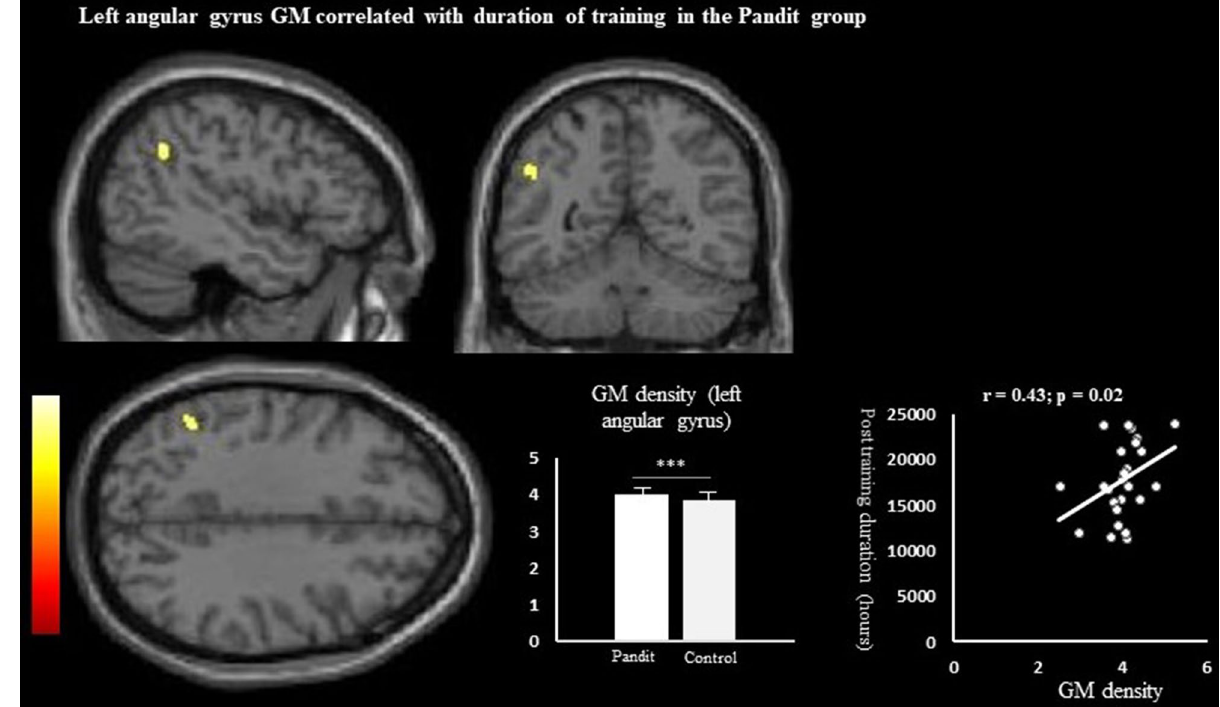
Figure 5. Result of the whole brain corelation analysis with GM value using length of post training teaching duration (hours) as a covariate in Pandit/Priest group. The result rendered into standard stereotactic space and superimposed on to transvers, sagittal and coronal section of magnetic resonance image (MRI) which is itself in standard space at a threshold of P < 0.05 (FWE) corrected. The figure also specifies GM density differences in two